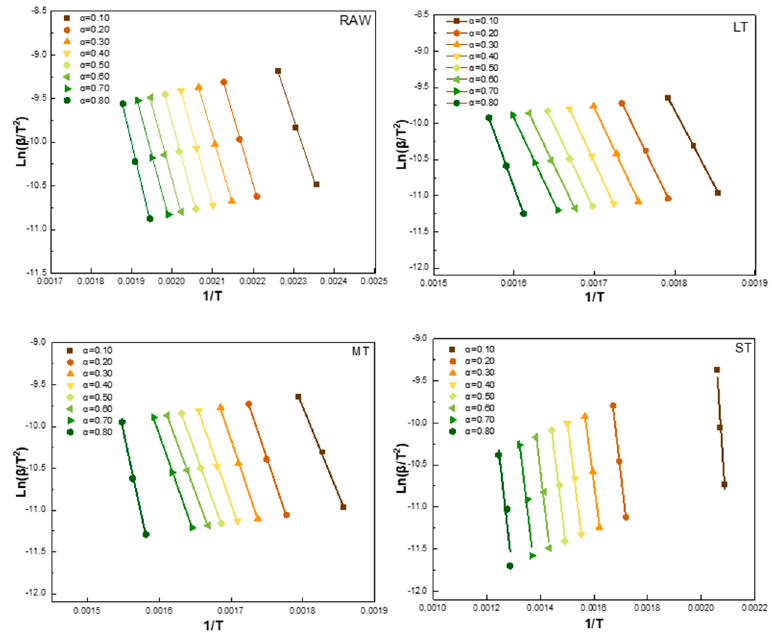
Figure 4. Arrhenius plots at various conversions ( α ) for pyrolysis of raw and torrefied corn cobs using the DAEM model.